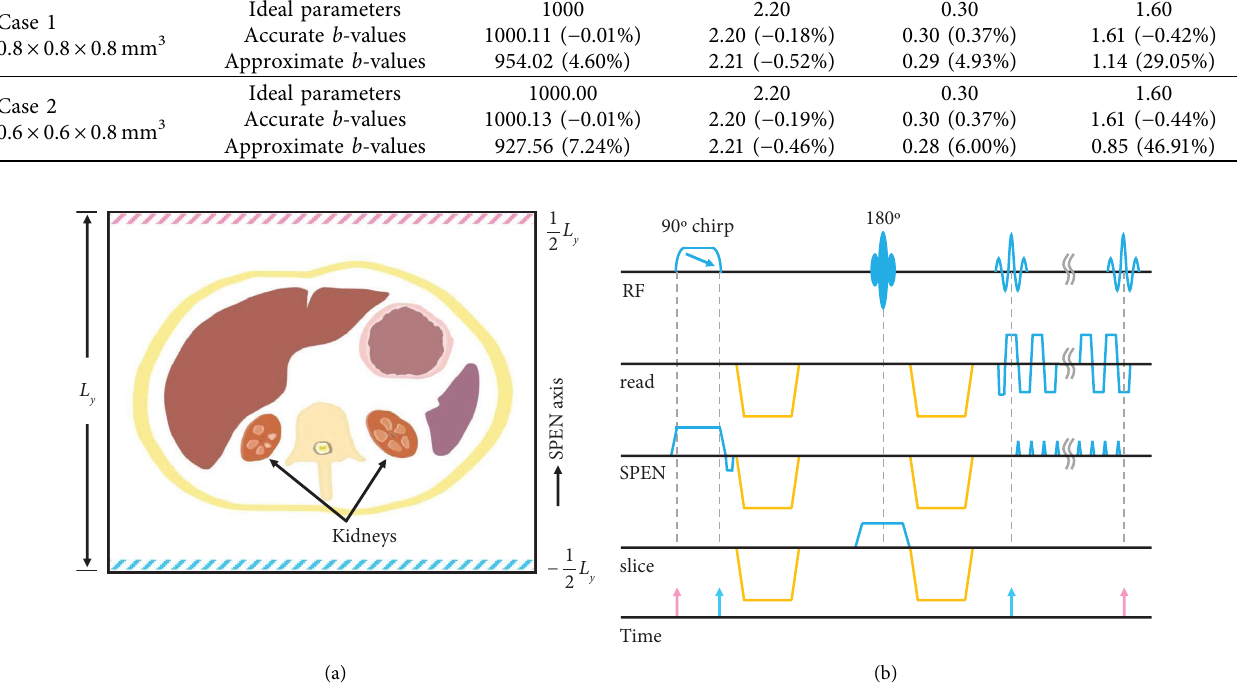
Table 5: Estimated physiological parameters and their relative error using accurate and nominal b -values in an optimized SE-EPI sequence. IVIM ftting results